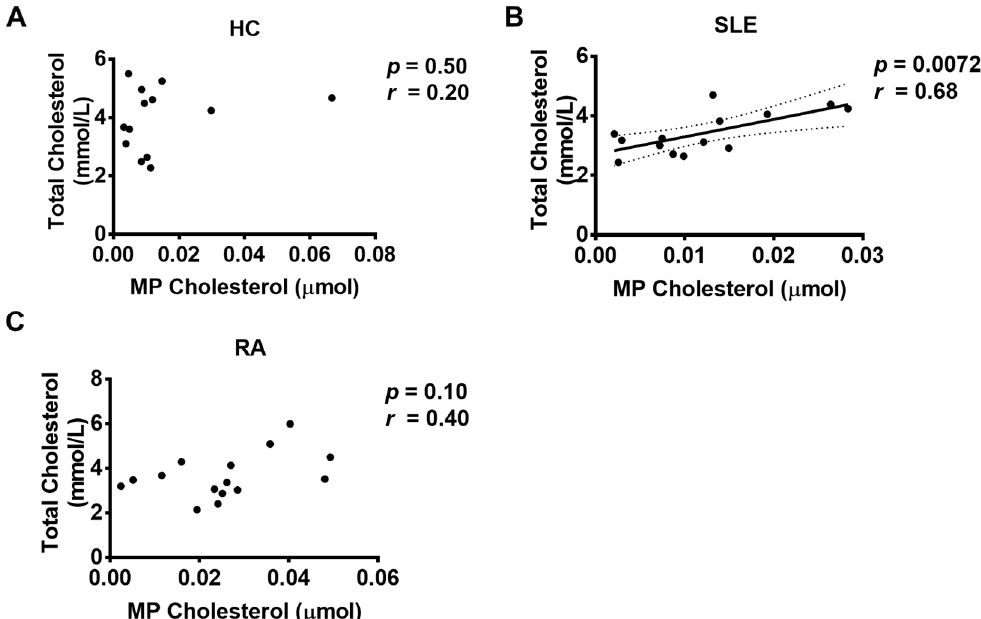
Figure 4. Correlations between total plasma cholesterol and microparticle (MP) cholesterol. There were no significant correlations between total plasma cholesterol and MP cholesterol from ( A ) healthy controls (HCs) or ( C ) Rheumatoid Arthritis (RA) patients, while there was a significant correlation in the case of ( B ) Systemic Lupus Erythematosus (SLE) ( p < 0.01).